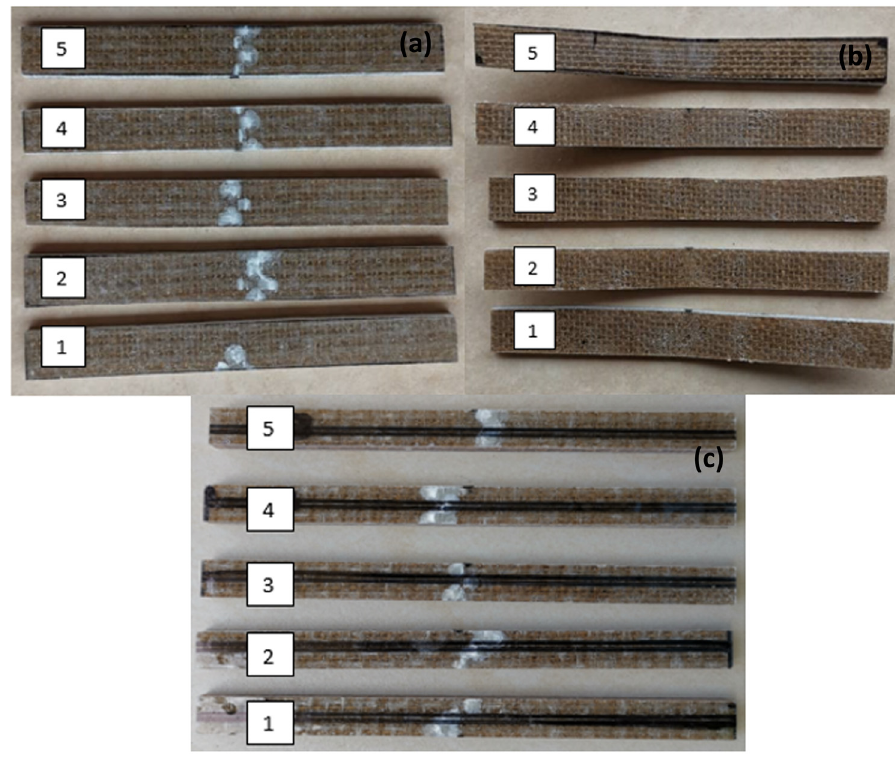
Figure 3: Composite sample after fl exural testing: ( a ) GKGKG, ( b ) KGKGK, and ( c )